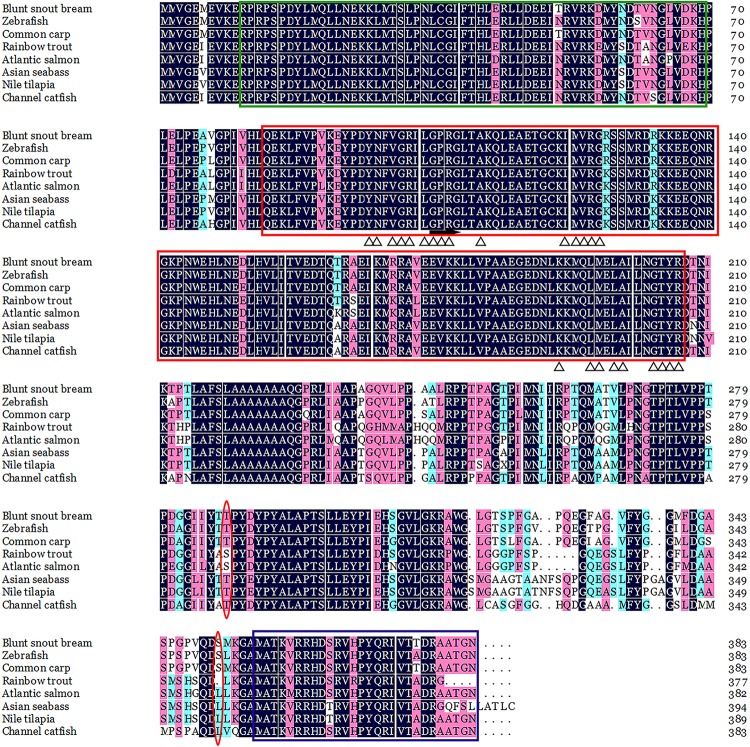
ClustalW alignment of the deduced AA sequence of the qkia protein from Megalobrama amblycephala and other organisms. Identical amino acids are marked in black and homologous amino acids in pink. The green, red and purple box indicate the STAR_dimer, SF1_like-KH and Quaking_NLS, respectively. Arrow and triangle indicates the G-X-X-G motif and potential RNA-binding sites, respectively. The phosphorylation sites are marked in red circle. The accession numbers for the sequences are as follows: blunt snout bream M. amblycephala (KY_444733), zebrafish (Danio rerio) (NP_571299.1), common carp (Cyprinus carpio) (XP_018921881.1), rainbow trout (Oncorhynchus mykiss) (CDQ_57984.1), Atlantic salmon (Salmo salar) (XP_013981550.1), Asian seabass Lates calcarifer (XP_018518983.1), Nile tilapia (Oreochromis niloticus) (XP_005464024.3), channel catfish (Ictalurus punctatus) (X _017331508.1).